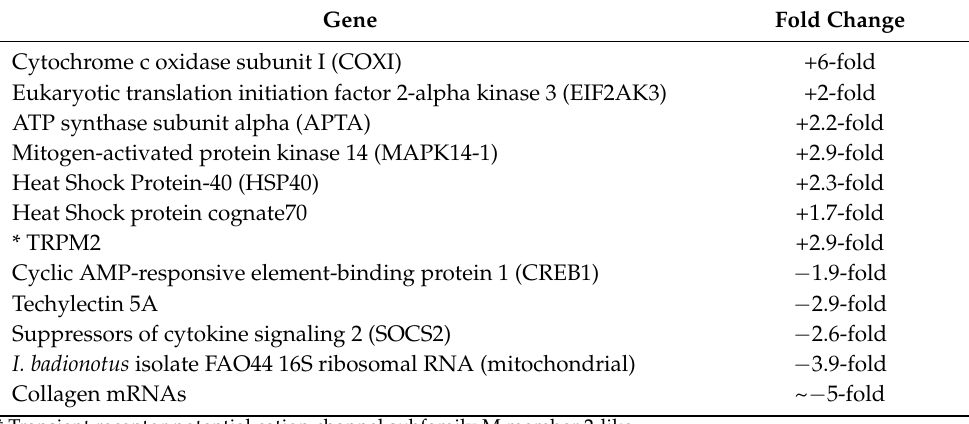
Table 2. Selection of transcripts differentially expressed in farmed I. badionotus . Gene Fold Change Cytochrome c oxidase subunit I (COXI) +6-fold Eukaryotic translation initiation factor 2-alpha kinase 3 (EIF2AK3) +2-fold ATP synthase subunit alpha (APTA) +2.2-fold